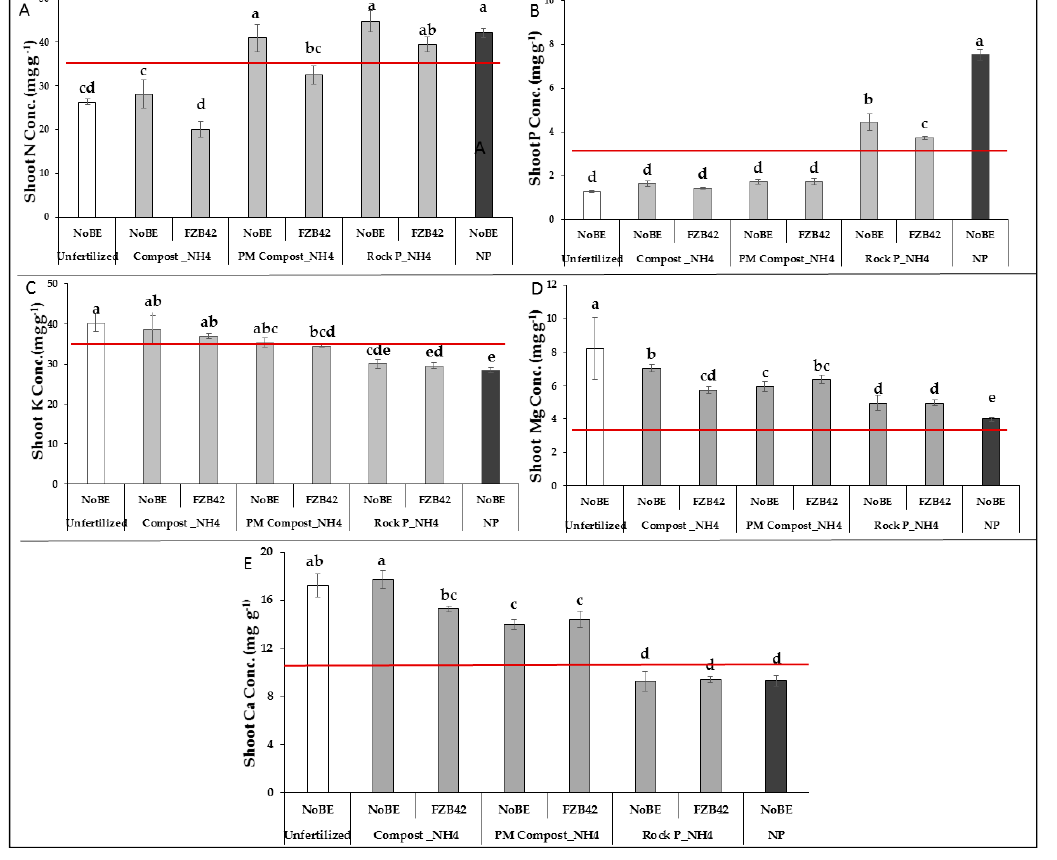
Figure 7. Effects of Bacillus amyloliquefaciens FZB42 inoculation on shoot N ( A ), P ( B ), K ( C ), Mg ( D ), and Ca ( E ) concentrations of 5-week-old tomatoes on pH 7.8 soil supplied with different fertilizers (Compost_NH 4 = municipal waste compost + stabilized ammonium sulfate, PM-Compost_NH 4 = municipal waste compost + poultry manure + stabilized ammonium sulfate, Rock P_NH 4 = rock phosphate +stabilized ammonium sulfate, NP = calcium nitrate plus superphosphate. The red lines represent the deficiency thresholds for nutrient tissue concentrations [22]. Means and SE of four replicates. Significant treatment differences are indicated by different letters (T-grouping (LSD) at p = 0.05). Table 3. Effects of Bacillus amyloliquefaciens FZB 42 inoculation on shoot accumulation of N, P, K, Mg, and Ca of 5-week-old tomatoes on pH 5.6 soil supplied with different fertilizers. (Compost_NH 4 = municipal waste compost + stabilized ammonium sulfate, PM-Compost_NH 4 = municipal waste compost + poultry manure + stabilized ammonium sulfate, Rock P_NH 4 = rock phosphate + stabilized ammonium sulfate, NP = calcium nitrate plus superphosphate). Means and SE of four replicates. Significant treatment differences are indicated by different letters (T-grouping (LSD) at p = 0.05). * = significant difference compared with the non-inoculated control (NoBE) within the same fertilizer treatment ( t -test at p < 0.05).